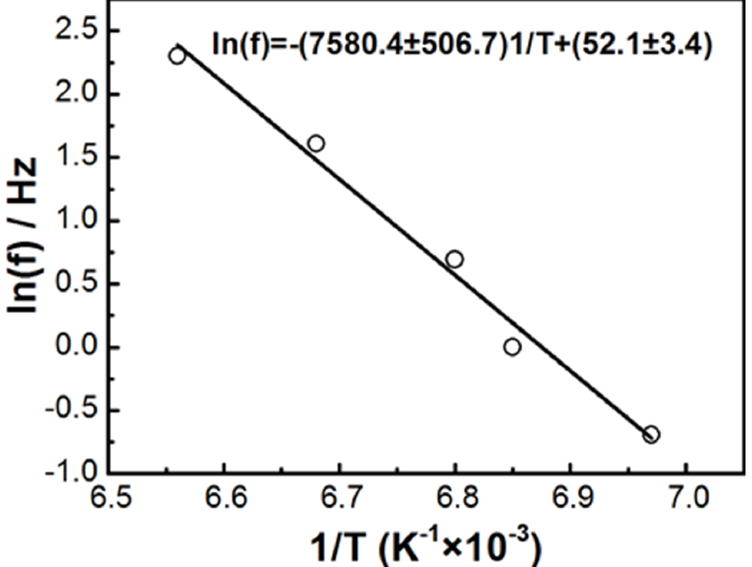
equation f = f 0 exp[ − E a /(RT)], where R is the gas constant, T is the peak temperature for the normalized loss modulus near 145 K, and f is the frequency. The activation energy E a was ~63 kJ/mol.